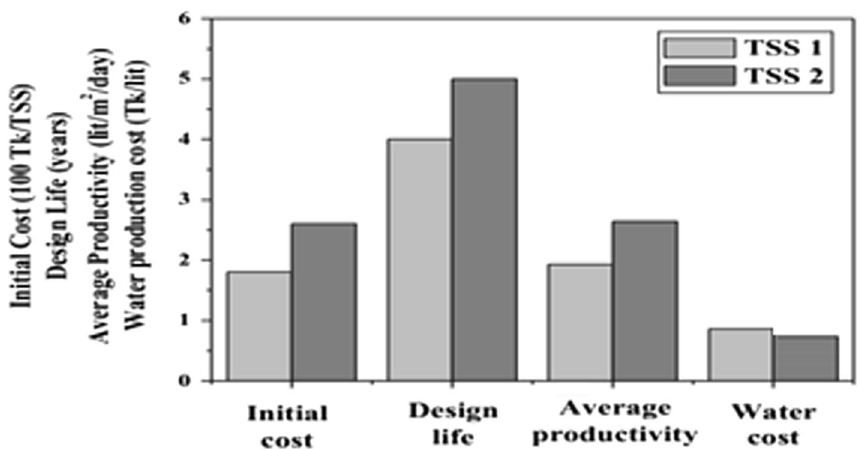
Fig. 6 Variation of design life, initial cost, average daily productivity and production cost for different